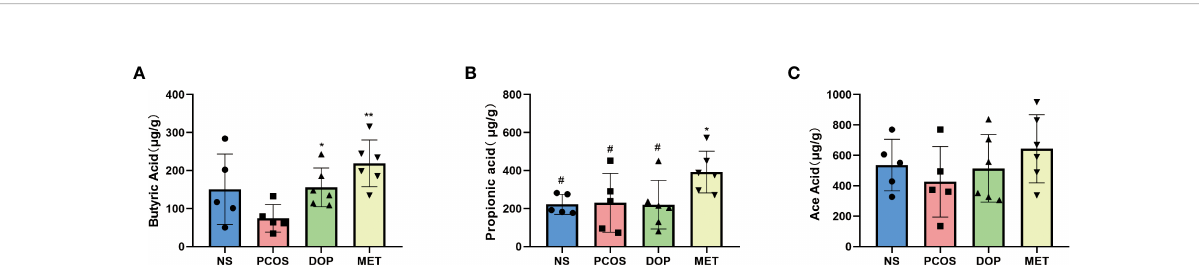
FIGURE 8 Effect of DOP treatment on fecal short-chain fatty acid (SCFA) levels, n = 5 – 6. Note: compared with the PCOS group * p < 0.05, ** p < 0.01; compared with the MET group # p <